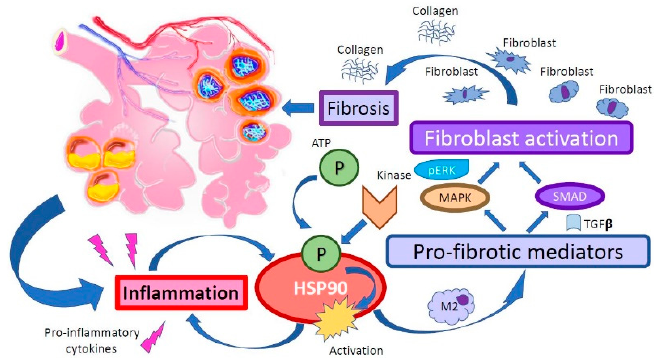
Figure 1. Heat shock protein 90 (HSP90) plays a role in the pro-fibrotic process in the lung that follows an inflammatory stimulus. Furthermore, it is involved in TGF- β signaling, fibroblast activation, and deposition of collagen.